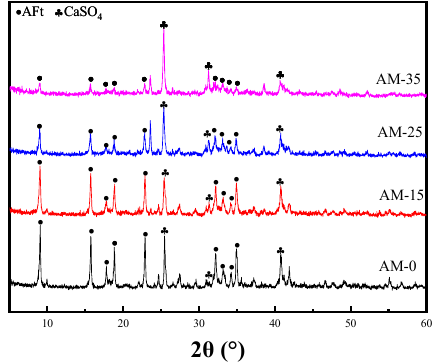
Figure 15. XRD pattern of 3 d specimens.